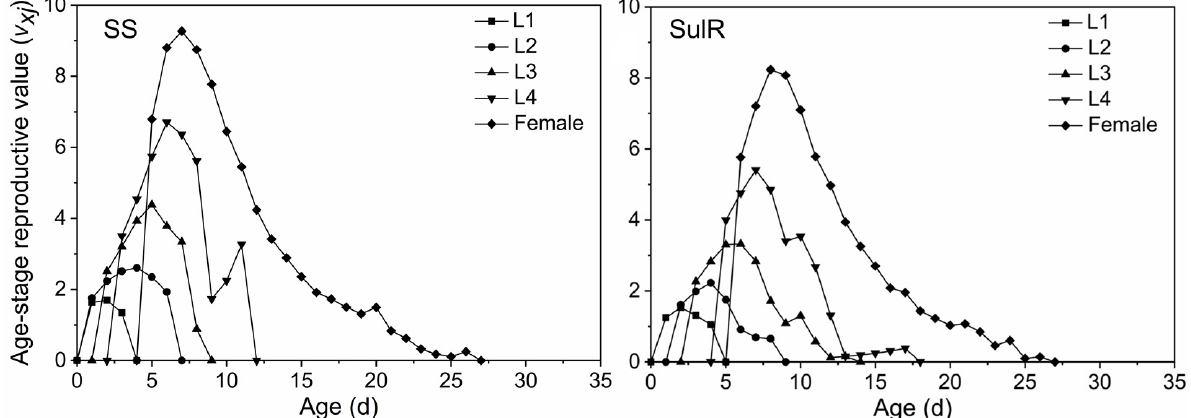
Figure 3. Age-stage-specific life expectancy ( e xj ) of sulfoxaflor-resistant (SulR) and sulfoxaflor-susceptible (SS) Sitobion miscanthi populations. L1, first nymph stage; L2, second nymph stage; L3, third nymph stage; L4, fourth nymph stage.